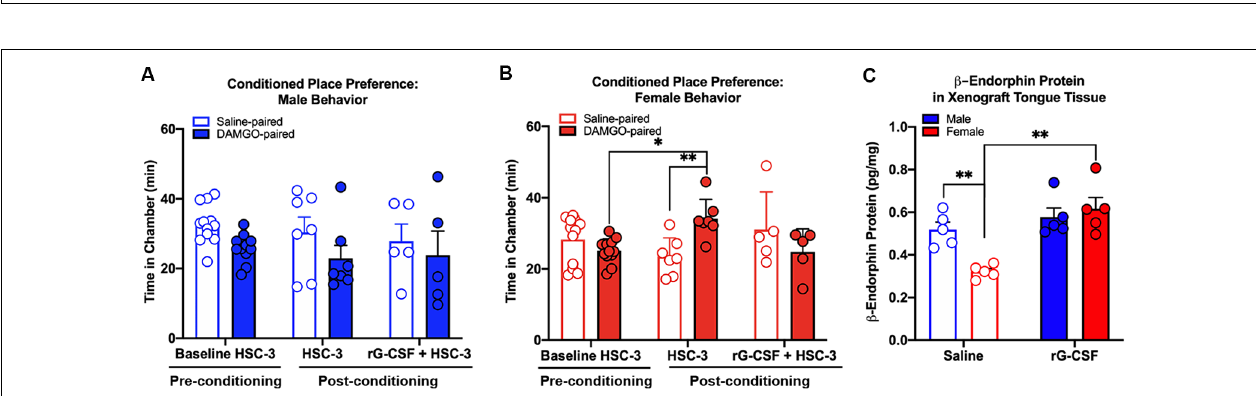
FIGURE 5 | Effect of oral cancer on conditioned place preference (CPP) to DAMGO. Mice were injected with HSC-3 cells into the tongue, habituated on day 21, conditioned with vehicle- and DAMGO (3 µ g/kg)-paired chamber for 1 h on days 22–24 and tested for CPP on day 25. Mice received saline ( N = 7/sex) or rG-CSF (2.5 µ g/mouse, N = 5/sex) 12 h prior to conditioning. The time spent in each chamber was quantified in tumor-bearing male (A) and female (B) mice. For all of the CPP experiments, pre-conditioning data (Baseline HSC-3) was analyzed using two-way ANOVA (chambers vs. treatment). Statistical analysis for chamber preference before conditioning revealed no difference in the time spent in chambers between saline and rG-CSF-treated mice ( P > 0.05), therefore baseline chamber data was pooled for graphical representation. Sexes were independently analyzed. Two-way ANOVA, ∗ P < 0.05, ∗∗ P < 0.01. (C) β -endorphin protein was quantified in homogenized tongue tissue from male (blue bars) and female (red bars) mice with HSC-3 xenograft tumors relative to total protein. Mice treated with either saline ( N = 5/sex, open bars) or rG-CSF ( N = 5/sex, closed bars). Two-way ANOVA, ∗∗ P < 0.01.